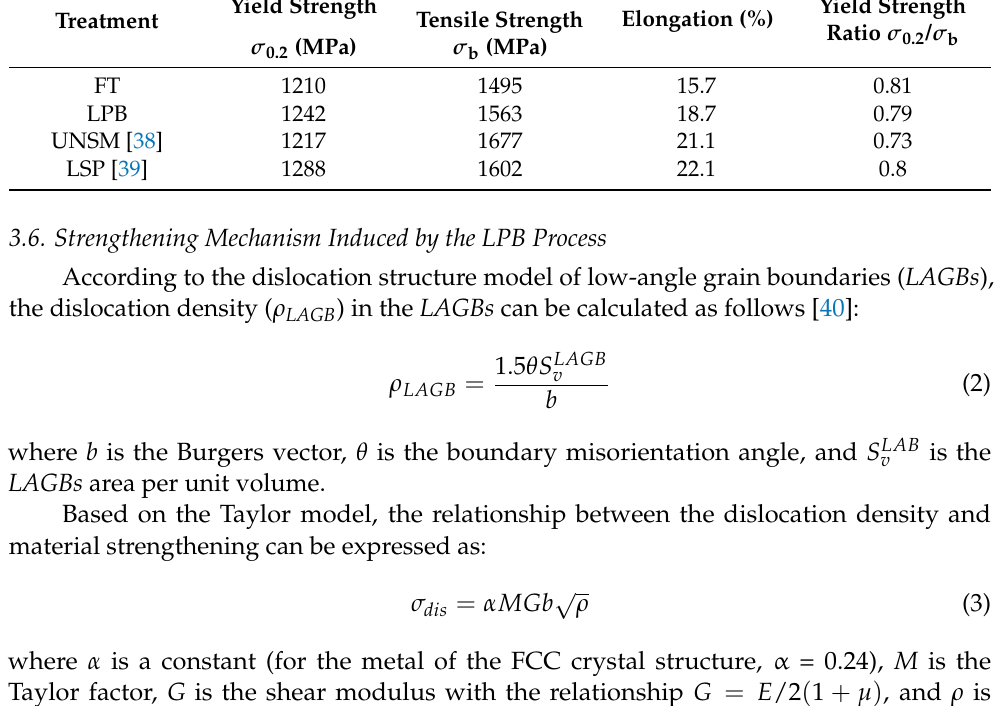
Table 3. Tensile properties of different treatments.